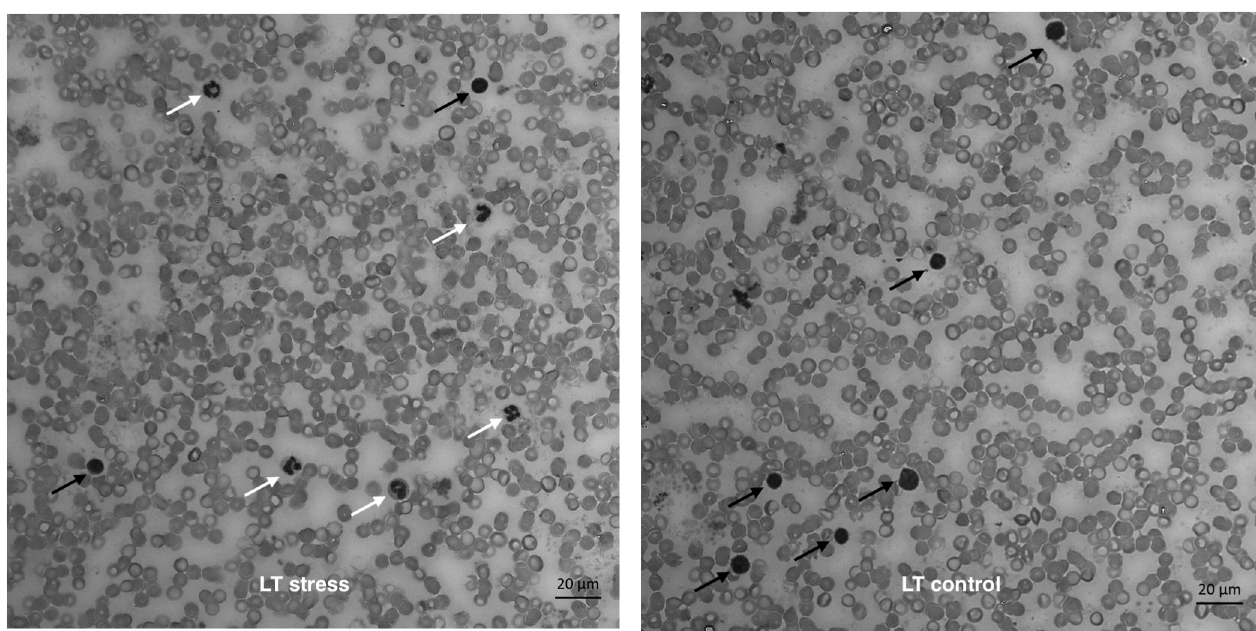
Fig 6. Neutrophils (white arrows) and lymphocytes (black arrows) in LT group before stress (right) and LT group 7 days after stress (left).